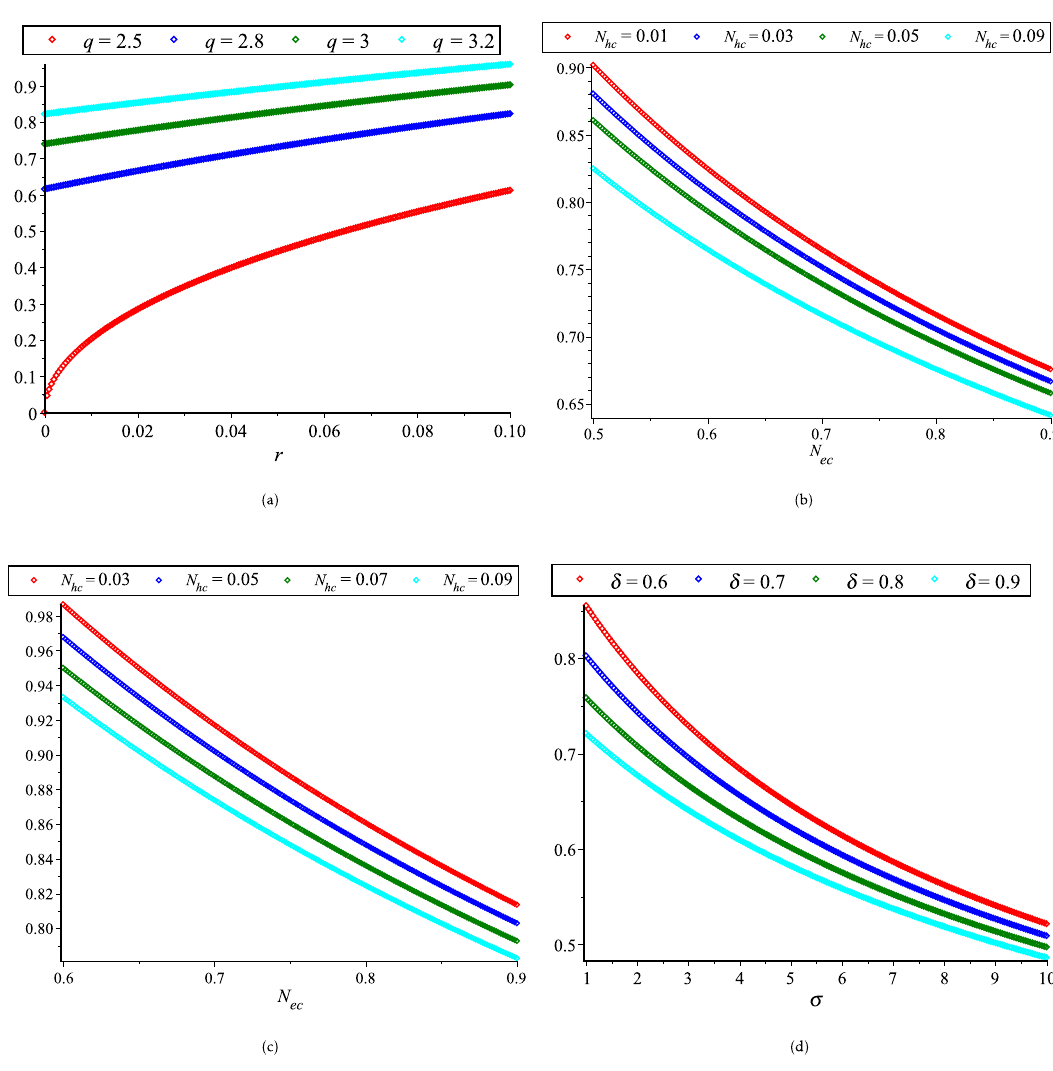
Figure 1. Variation of λ p with regards to ( a ) r for different values of q with N hc = 0.09, N ec = 0.65, δ = 0.8 and σ = 1; ( b ) N ec for different values of N hc with r = 0, q = 3, δ = 0.8 and σ = 1; ( c ) N ec for different values of N hc with r = 0.1, q = 3, δ = 0.8 and σ = 1; and ( d ) σ for different values of δ with N hc = 0.09, N ec = 0.65, q = 3 and r =